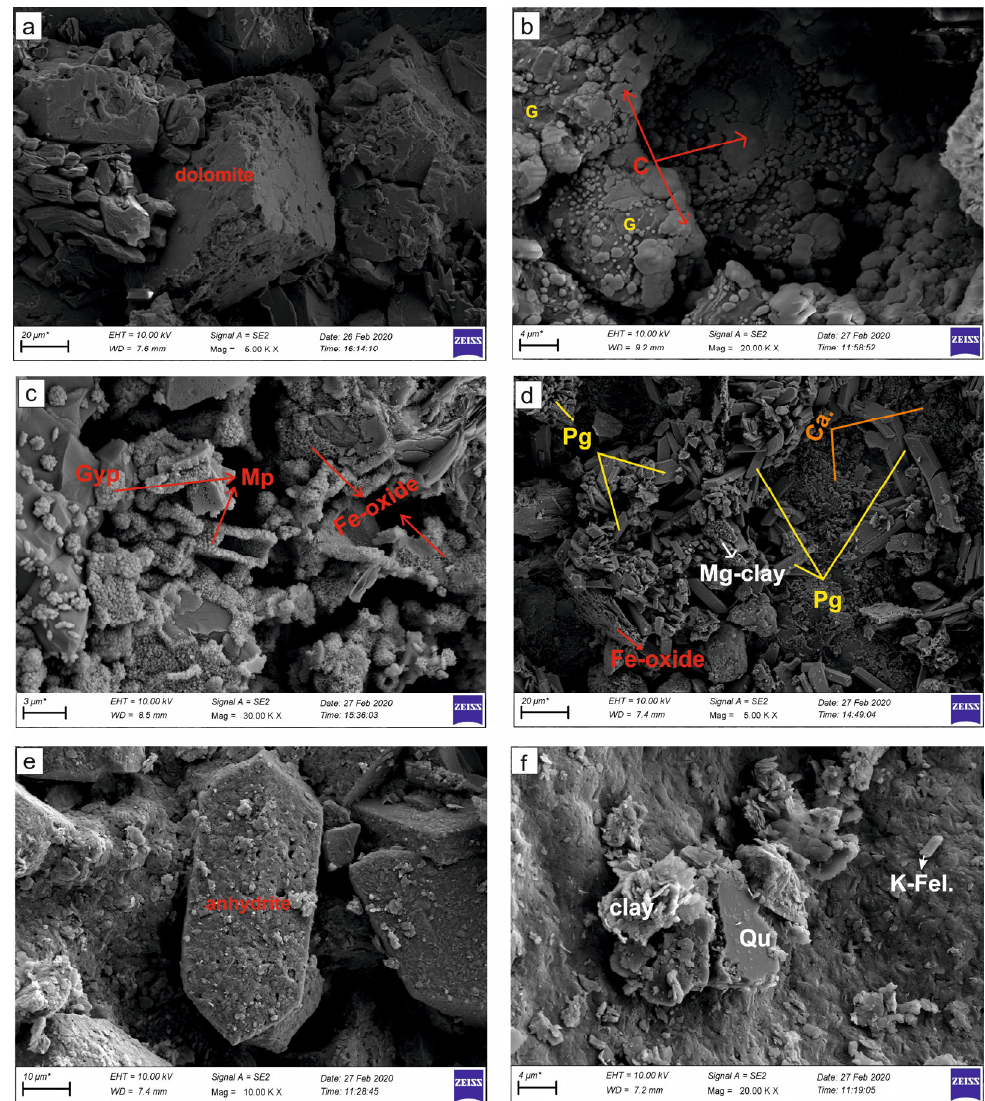
Figure 6. SEM images of the evaporitic rock samples. ( a ) Euhedral semi-euhedral rhombohedral dolomite minerals in massive-laminated gypsum (K-11 Köprüa˘gzı); ( b ) the nodular-shaped celestine (C) replacing secondary gypsum (G) (OBK-5 Gönen); ( c ) microbial pyrite (Mp) formations and Fe-oxidation in the gypsum (Gyp) (K-5 Köprüa˘gzı); ( d ) the plate-like formed Mg-rich clay minerals, Fe-oxide and carbonatization (Ca.) areas in the prismatic gypsum (Pg) (O-6 Örenkale); ( e ) orthorhombic prismatic anhydrite (Anh) crystal; ( f ) Mg-rich clay, quartz (Qu) and potassium feldspar (K Fel.) minerals in gypsum (O-6 Örenkale).